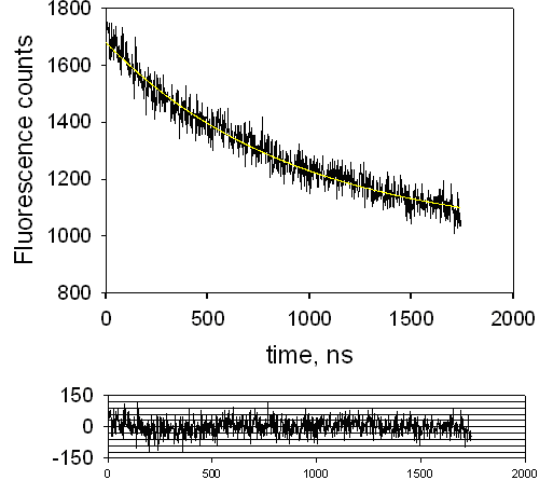
Fig. 8. Typical phosphorescence trace of Ru complex-loaded nanoparticles taken up by HDF cells. The value of the lifetime was 0.93 (cid:1) s. The ¯tted line is shown as the smooth line. The bottom panel shows the residuals: these were due to the back- ground counts recorded in complete darkness. Reproduced with permission from Williams et al. 48